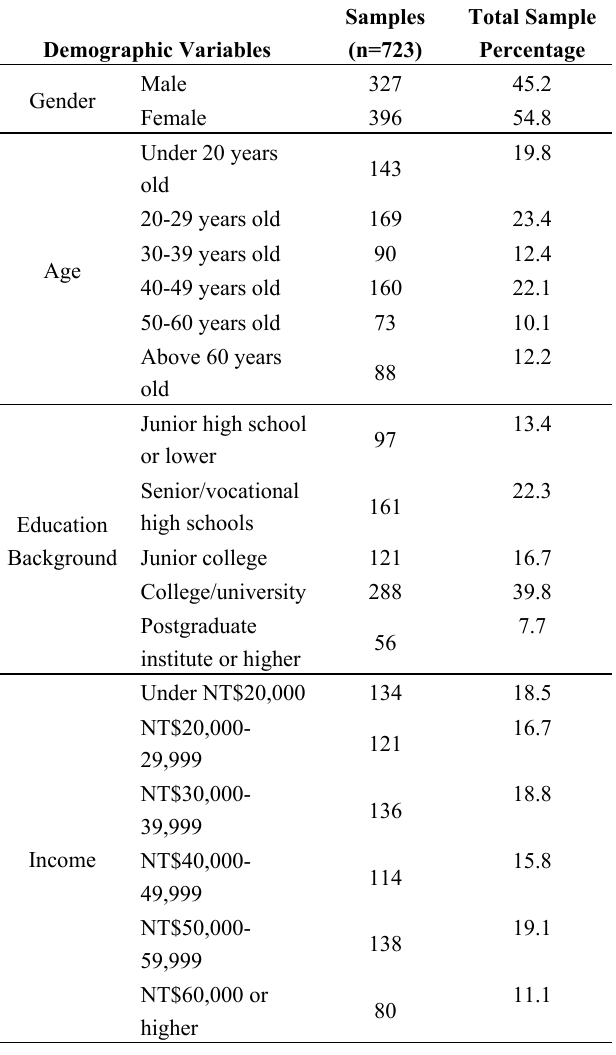
Table 3: The background statistics of the samples